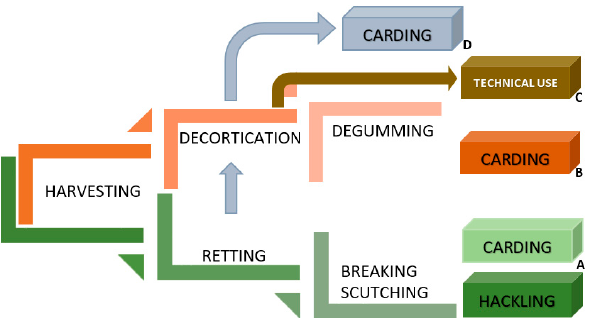
Figure 16. Schematic value chains of hemp fibre extraction for textile purposes. ( A ) (green line)— traditional order of processes including straw retting, ( B ) (orange line)—with use of decortication of straw excluding retting with use of degumming, ( C ) (orange-brown line)—decortication of raw non-retted straw for technical use of the fibres, ( D ) (green-grey line)—with use of decortication following retting aimed at preparation of fibre for cottonisation or woolenisation ( own elaboration ).